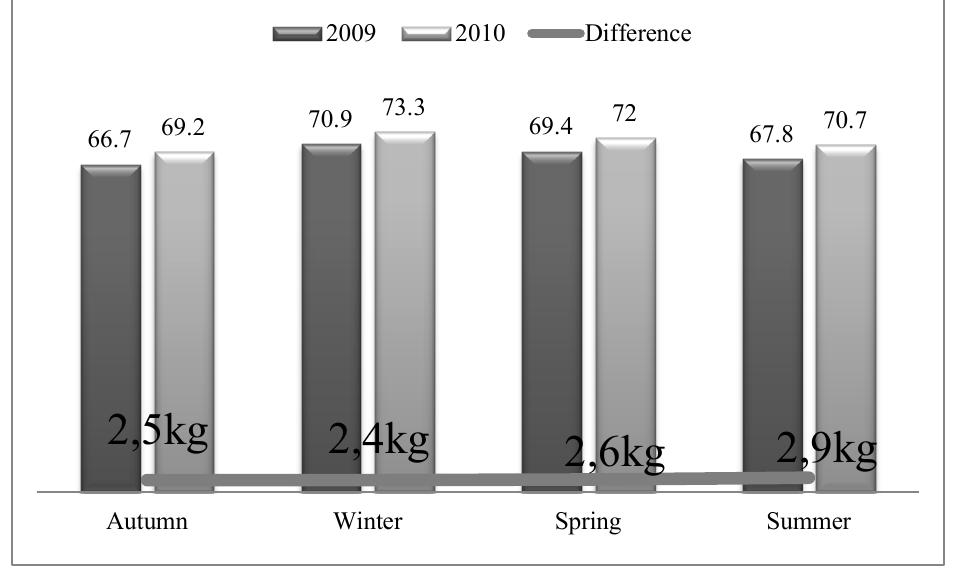
Table 4. The BMI values of participants according to regions and seasons ( standard